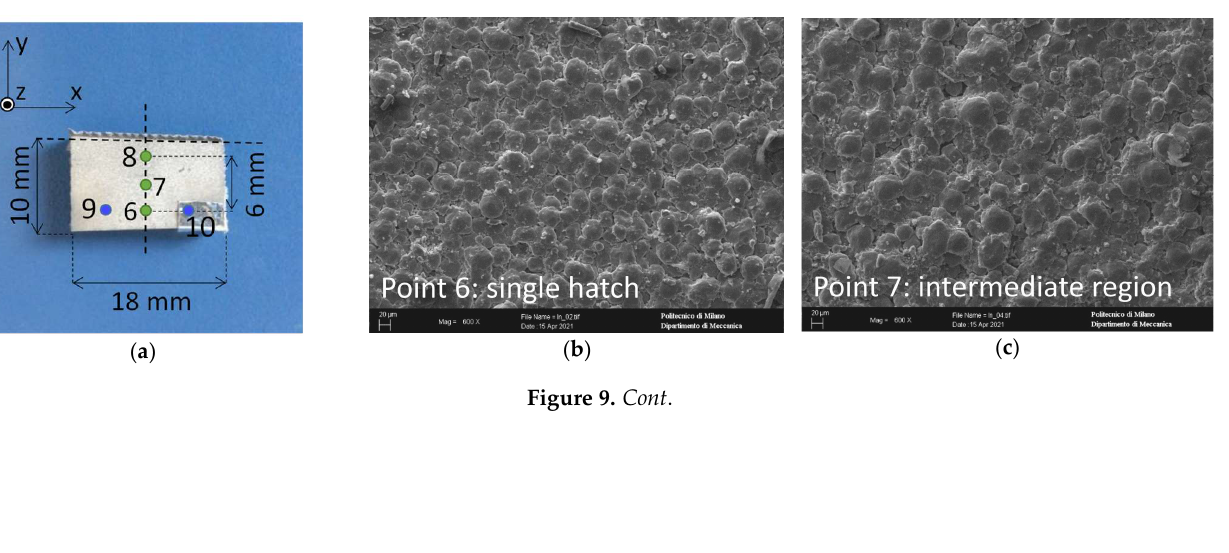
Figure 8. Specimen S1 , through-thickness analysis: ( a ) points location; ( b–f ) SEM-magnified images of the five points.